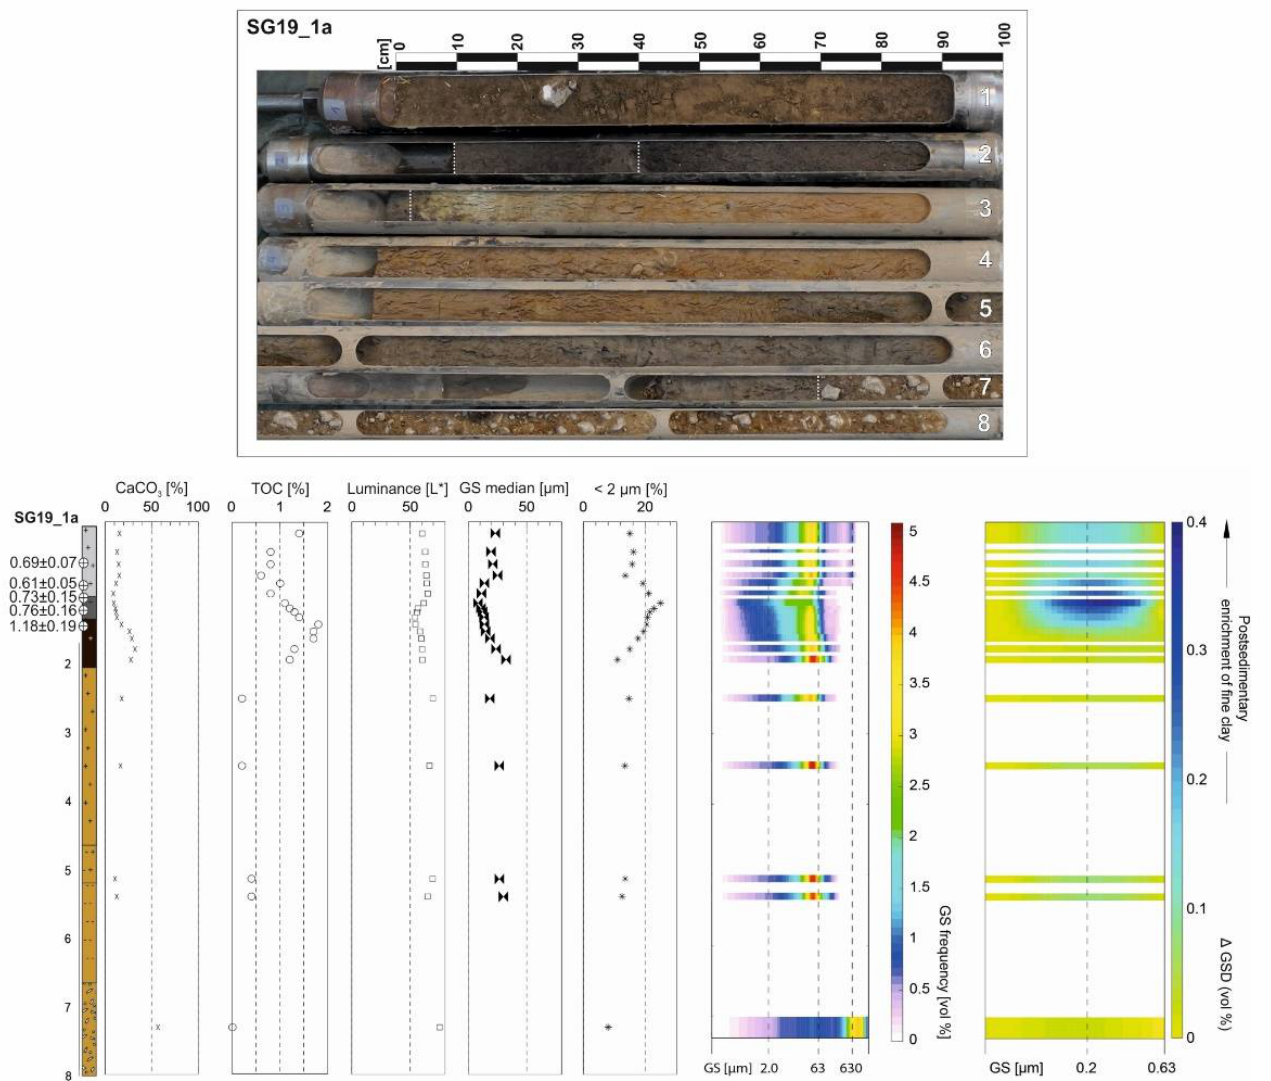
Figure 6. ( Top ) Drilling core SG19_1a showing gravelly to sandy slope debris (6.7 to 8.0 m) covered by loess and loess-like sediments (1.4 to 6.7 m), with a developed gleyic Chernozem between 1.4 and 2.0 m. Above (<1.4 m) overbank fines were drilled which are influenced by ploughing in the uppermost 0.3 m. ( Bottom ) Laboratory results obtained for drilling core SG19_1a. The schematic illustration (left of the graphs) refers to Figure 4.